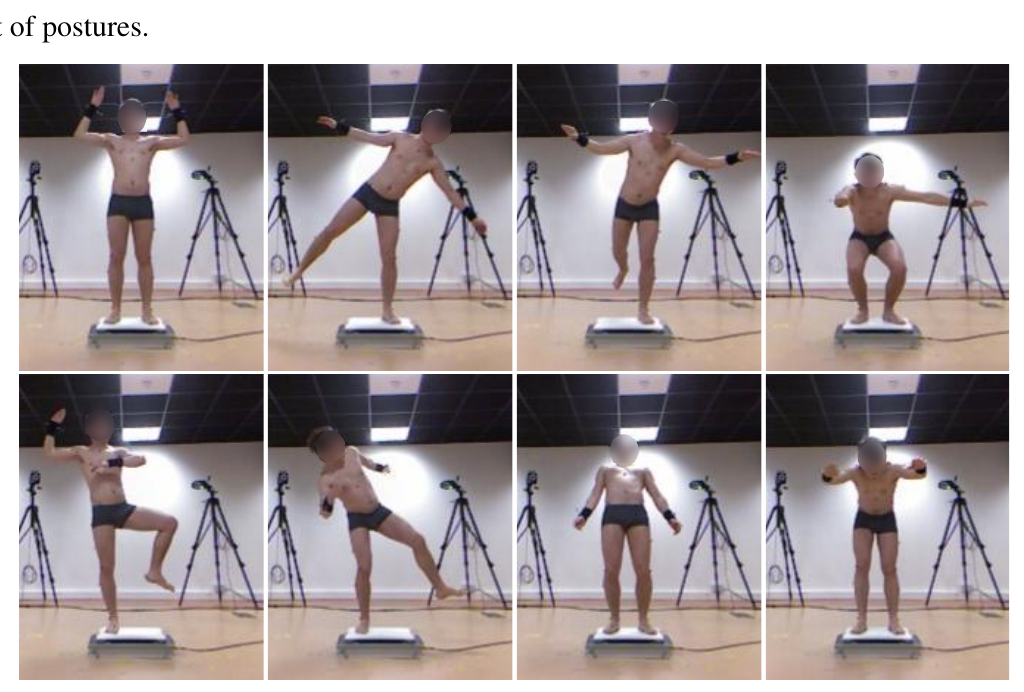
Figure 2. Synchronous recording of Vicon-AMTI-OR6 (AMTI6 by Advanced Mechanical Technology, Inc.) and Kinect-Wii balance board (WBB by Nintendo R ⃝